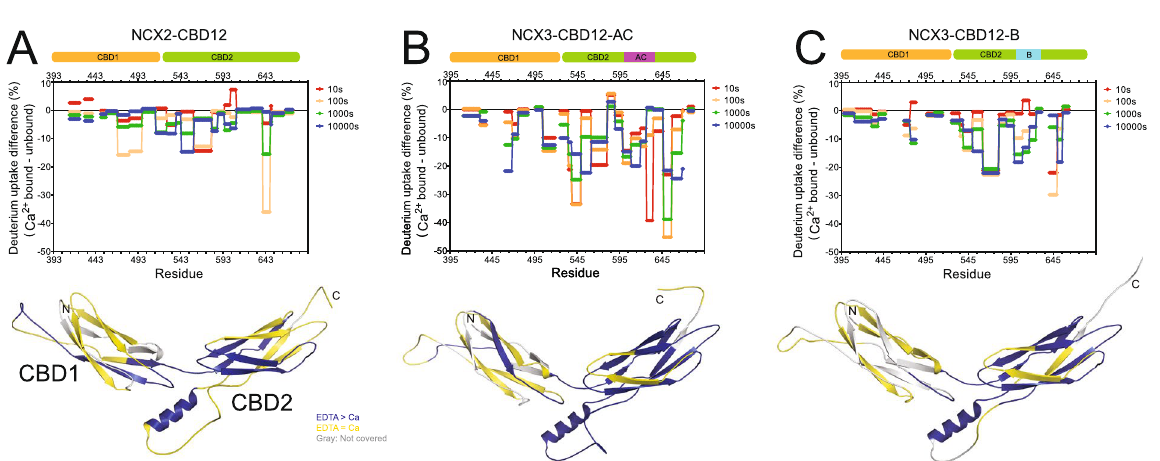
Figure 5. Effect of Ca 2 + binding on NCX2-CBD12 and NCX3-CBD12 dynamics. Deuterium uptake differences between the Ca 2 + -bound form and the apo form as a function of residue at different time points as indicated are plotted for NCX2-CBD12 ( A ), NCX3-CBD12-AC ( B ), and NCX3-CBD12-B ( C ). The data are also qualitatively depicted on the models of NCX2-CBD12 ( A ), NCX3-CBD12-AC ( B ), and NCX3-CBD12-B ( C ). Regions with lower deuterium uptake in the Ca 2 + -bound form are in blue, regions with similar deuterium uptake in the Ca 2 + - bound form and apo form are in yellow, and regions not covered by the detected peptic peptides are in